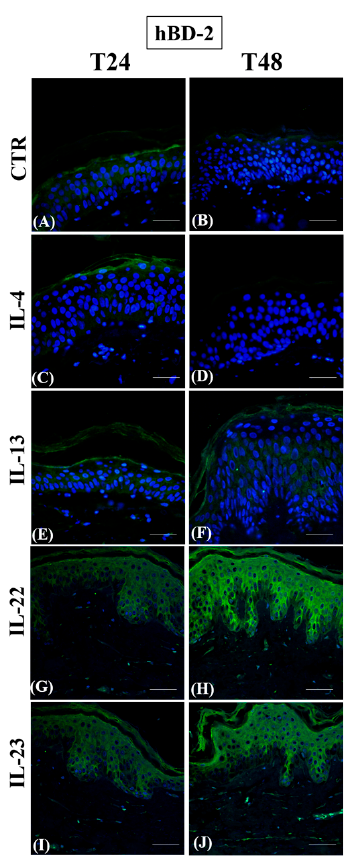
Figure 7. Immunofluorescence of hBD-2 expression on paraffin human skin sections. Representative hBD-2 immunostaining in normal human skin paraffin sections. ( A , C , E , G , I ): samples harvested at 24 h; ( B , D , F , H , J ): samples harvested at 48 h. ( A , B ): CTR samples; ( C , D ): IL-4-treated samples; ( E , F ): IL-13-treated samples; ( G , H ): IL-22-treated samples; ( I , J ): IL-23-treated samples. Nuclei are counter- stained with DAPI. hBD-2: human beta-defensin 2. CTR: control; IL-4: interleukin 4; IL-13: interleukin 13; IL-22: interleukin 22; IL-23: interleukin 23; DAPI: 4 (cid:48) , 6-diamidino-2-phenylindoledihydrochloride— scale bars: 50 µ